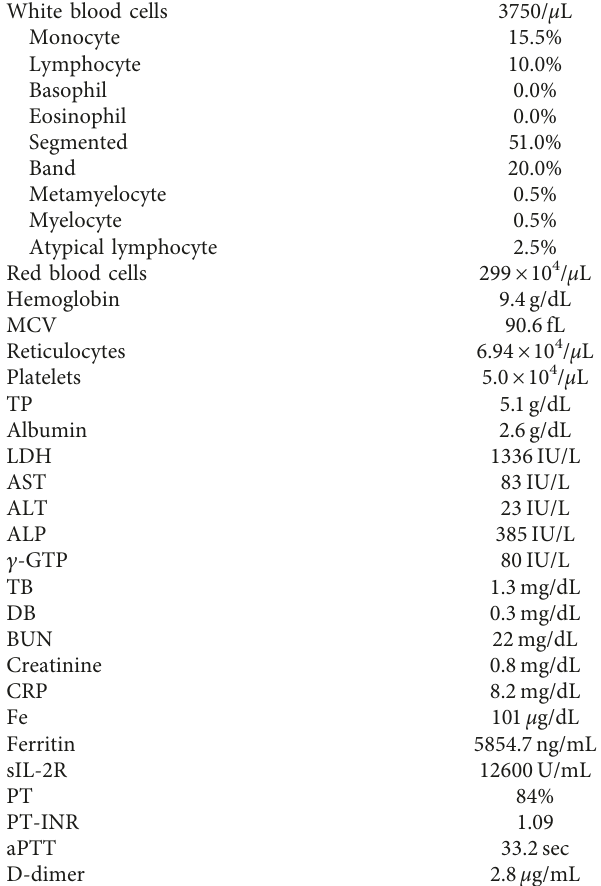
Table 1: Summary of the patient’s initial laboratory